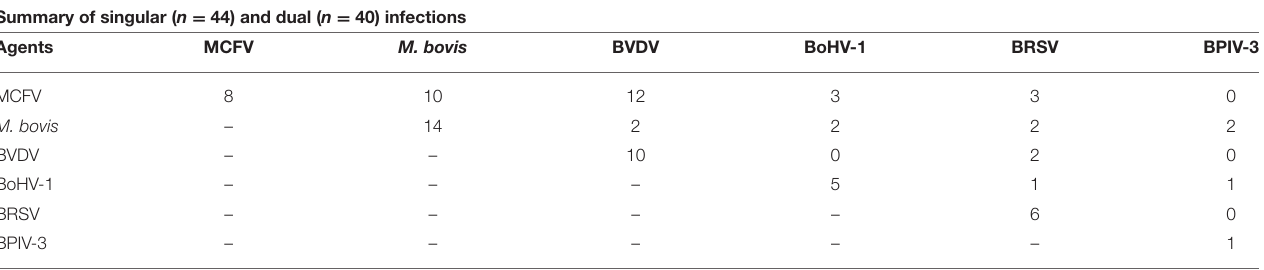
TABLE 4 | Distribution of the IHC identification of intralesional antigens in the development of singular and concomitant infections in the lungs of cattle with pneumonia ( n = 120). Summary of singular ( n = 44) and dual ( n = 40) infections Agents MCFV M. bovis BVDV BoHV-1 BRSV BPIV-3 MCFV 8 10